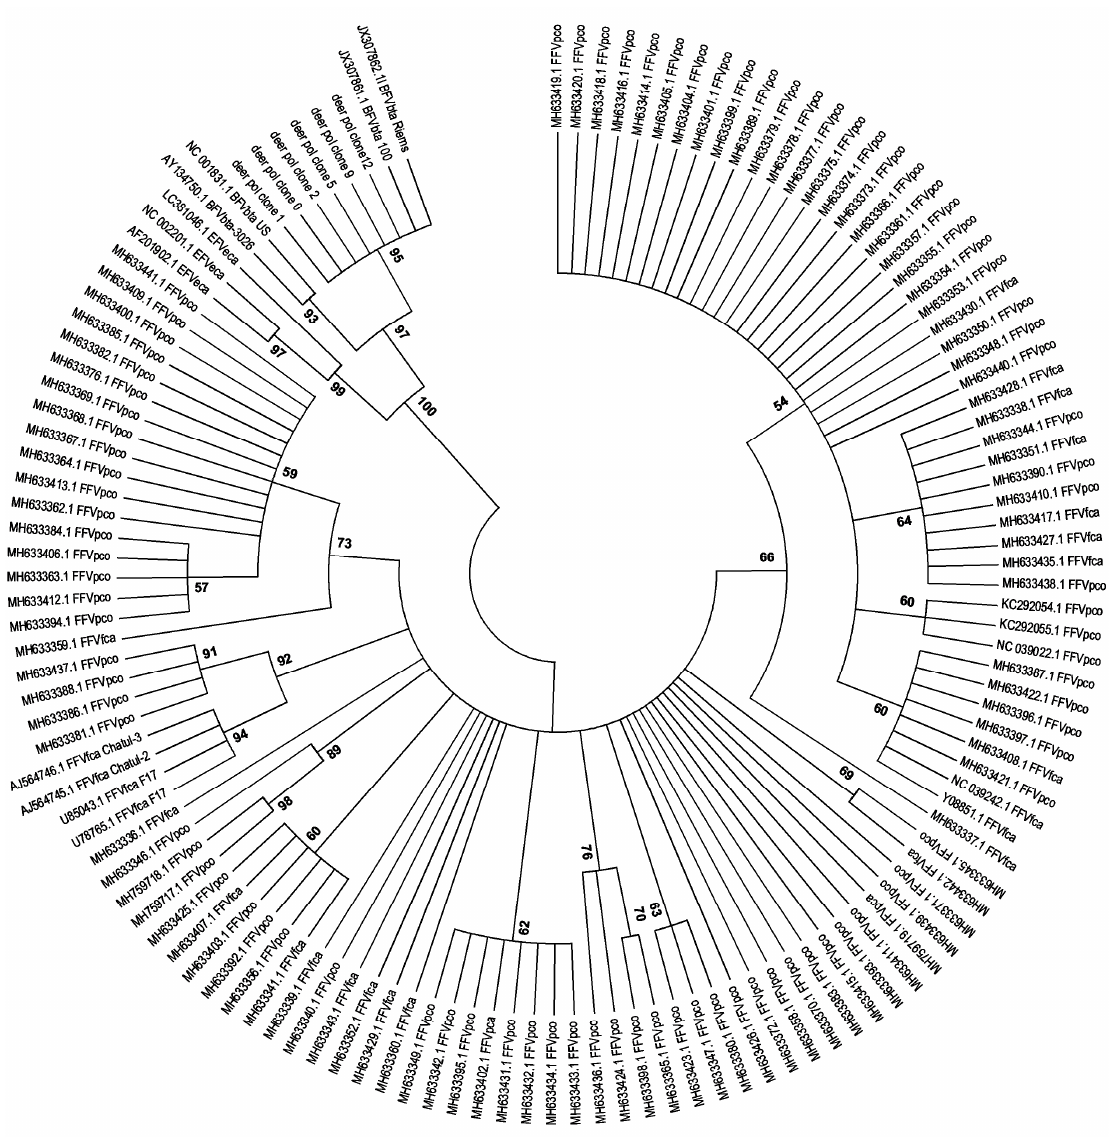
Figure 5. Phylogenetic tree inferred from the 275 bp amplicons of the pol region from deer 113 / 13 and extracted from the sequences of all BFV, EFV, and FFV isolates (the majority of the sequences) available in GenBank. The origin of FV isolates has been indicated as follows: BFVbta, cow ( Bos taurus ); EFVeca, horse ( Equus caballus ); FFVfca, cat ( Felis catus ); FFVpco, mountain lion ( Puma concolor ). All analyzed sequences were devoid of primer sequences. The tree was generated with MEGA 6.0 software by maximum likelihood method and presented with condensed branches.